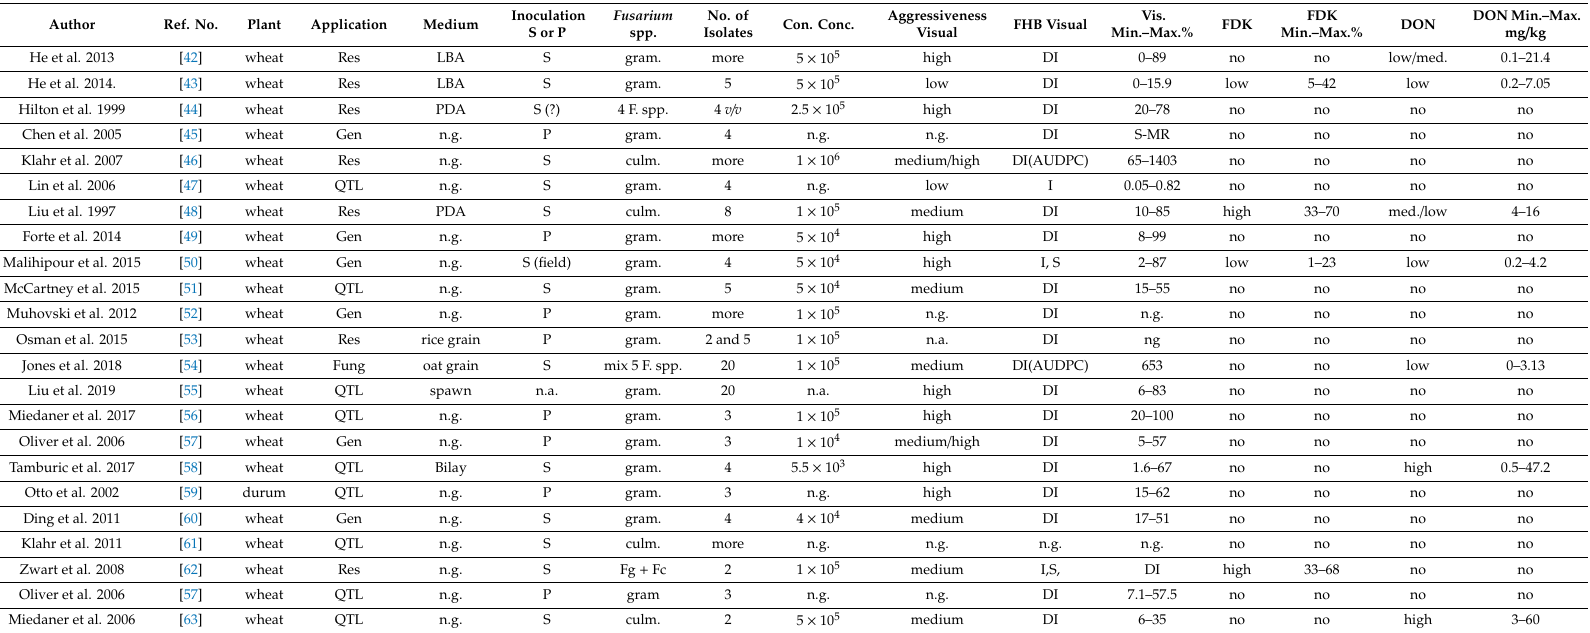
The whole table: n.g. = not given, no = not tested, n.a. not applicable, Headings: Plants: trit. = triticale, Application: Path = pathology, Fung: fungicide research, Res = resistance research, tests, Gen = genetic aspects, QTL: quantitative traits locus Medium to increase fungi: LBA = lima bean medium MBA = mung bean agar, MBM mungo been medium liquid PDA = potato dextrose agar, CMC = carboxyl methyl cellulose, SNA = synthetic nutrient-poor agar, Inoculation of ears: S = spray, P = point, Fusarium spp.: gram. = graminearum, culm. = culmorum, Fg + Fc: mixture of the two species. No. of isolates: v / v volume / volume, when 4, each have 25% in the pooled inoculum, nFg, nFc, = mixture of the two species without giving the number of the isolates, therefor “n” before, Conidium concentration: 1 × 10 4 , 1 × 10 5 : = two di ff erent concentrations were used in the same paper, FHB (Fusarium head blight) Visual: * = 20 days after inoculations, I = Incidence, S = severity, VSS 1–9 = visual scale 1–9, DI = disease index, DAI = Days after inoculation.: AUDPC: area under disease progress curve, FDK = Fusarium damaged kernel, DON: